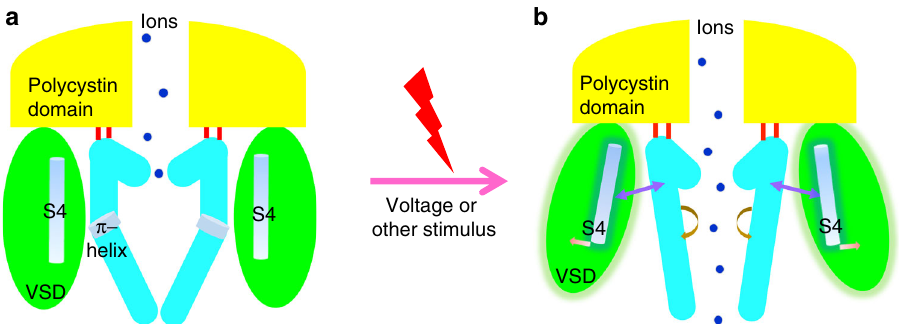
Fig. 6 Hypothetical model for PKD2L1 gating mechanisms. Mechanisms of gating for PKD2L1 channels can be described as shown in the schematic. The closed-state of PKD2L1 depicted by the homologous model of PKD2 structure ( a ) implies the non-conductive state blocked hypothetically by sodium ions (marine dots). PKD2L1 represents the conductive state ( b ). The polycystin domain remains relatively static (a slightly outward eversion) during the gating process independent of the state. When the channel switches from closed to open in response to voltage or other physiological stimuli, its pore coupled with VSD motions dilates both the lower gate and the upper gate by an iris-like (for S6) and clock-like (for VSD)